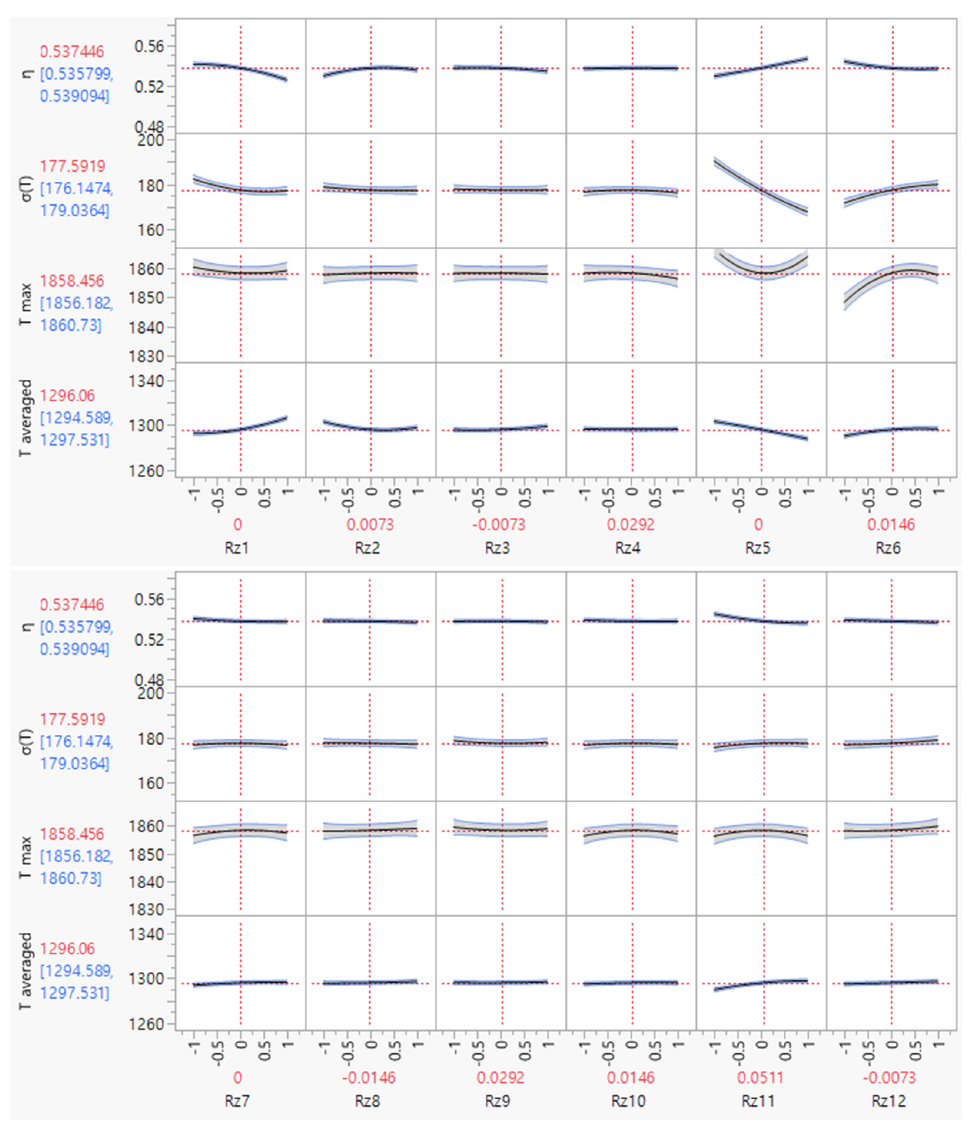
Figure 8. Sensitivity chart for the cooling performance (adapted with permission from [16]; copyright 2021 Korean Society for Fluid Machinery).